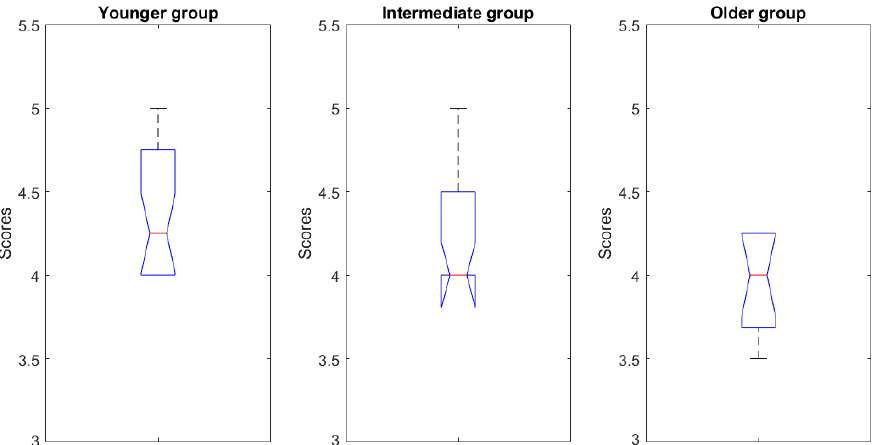
Figure 5. Statistics of the scores given to questions related to participants’ attitudes towards technol- ogy, divided according to the three age ranges that we identified.